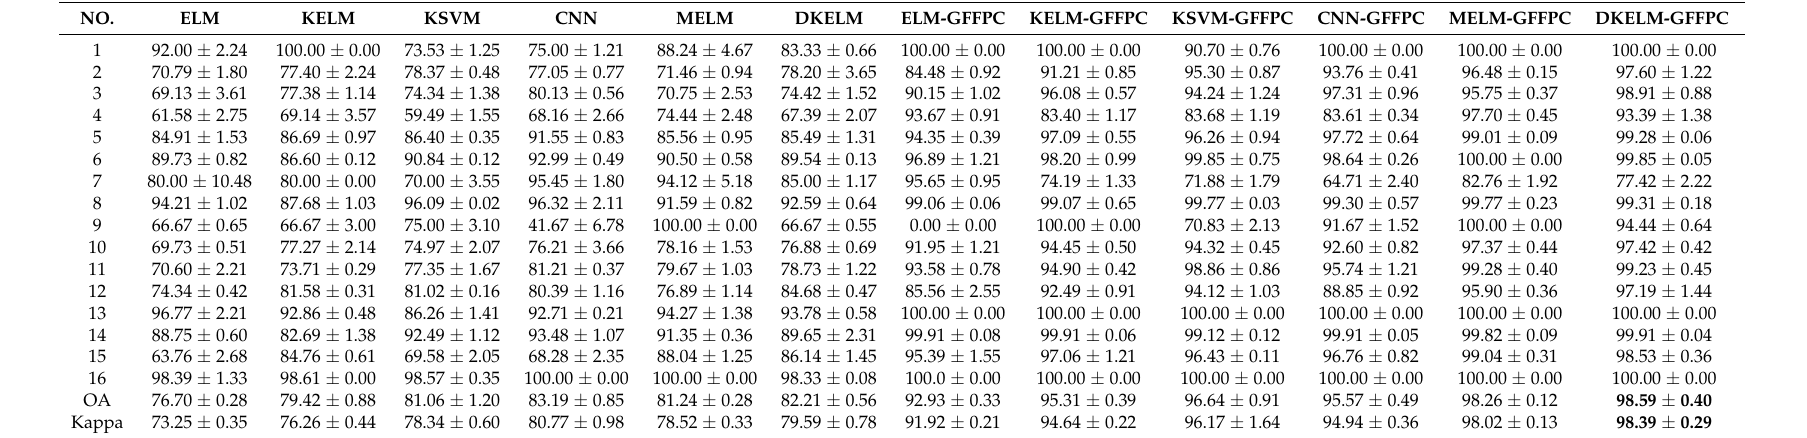
Table 5. Classification Accuracy(%) of the comparison and proposed algorithms in Indian Pines.